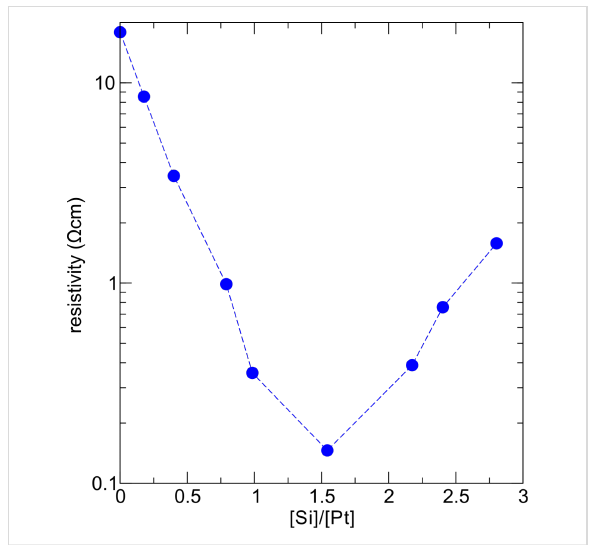
Figure 7: Dependence of the room temperature resistivity on the Si/Pt ratio in the FEBID samples according to [28].